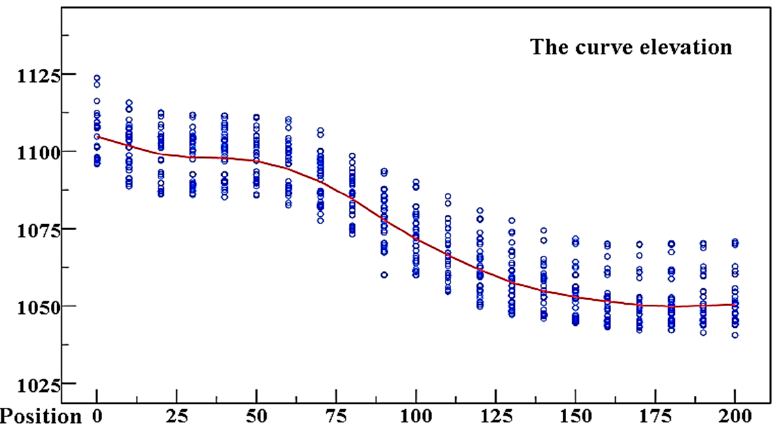
Figure 15. Fitting the cast blasting stockpile profile of the 45 m step height.